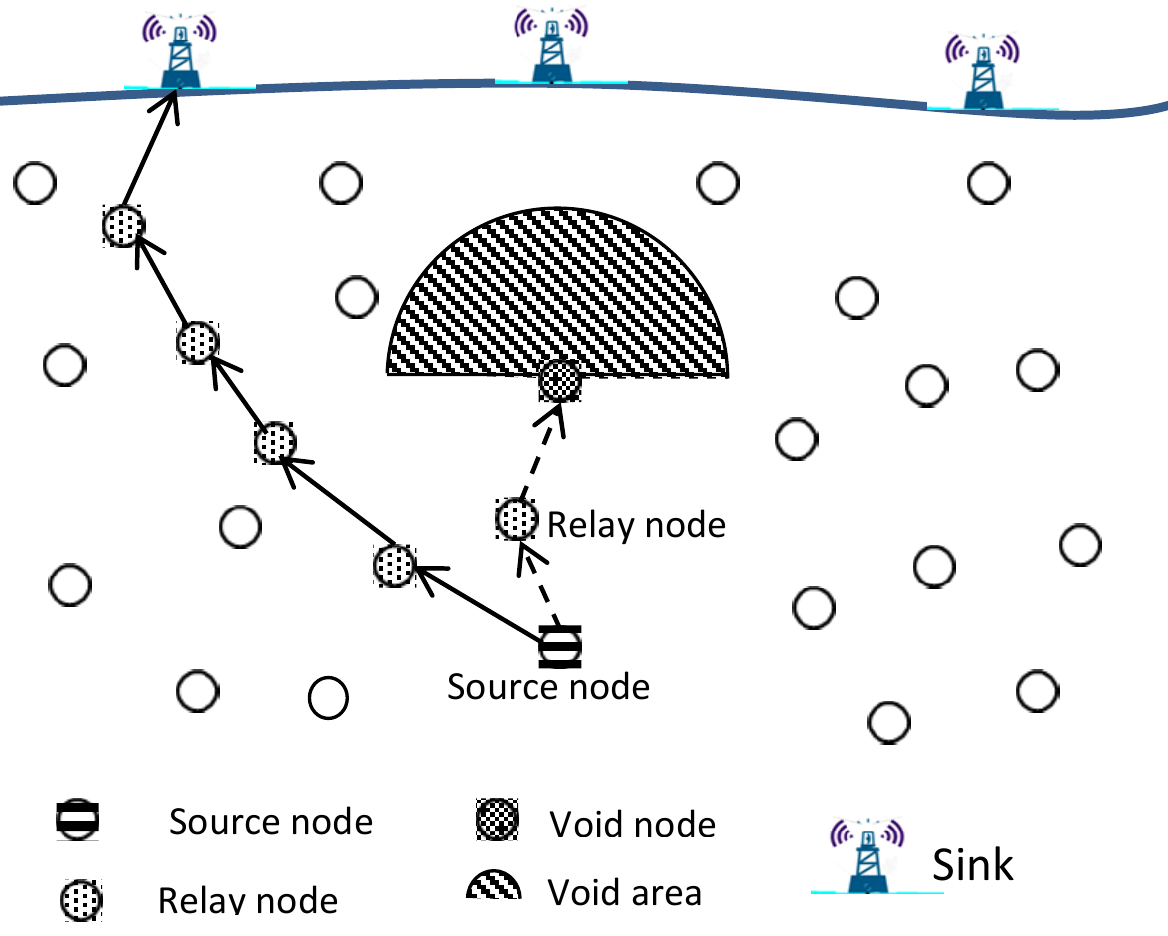
Figure 1. Void area in UWSN architecture.